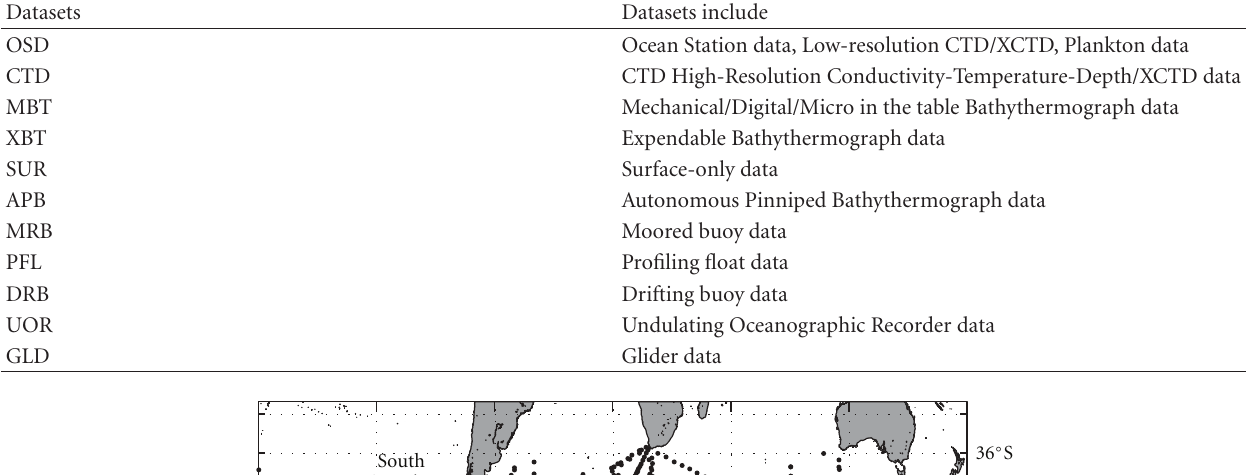
Table 1: Instrument types in the World Ocean Database. (http://www.nodc.noaa.gov/OC5/WOD05/pr wod05.html).